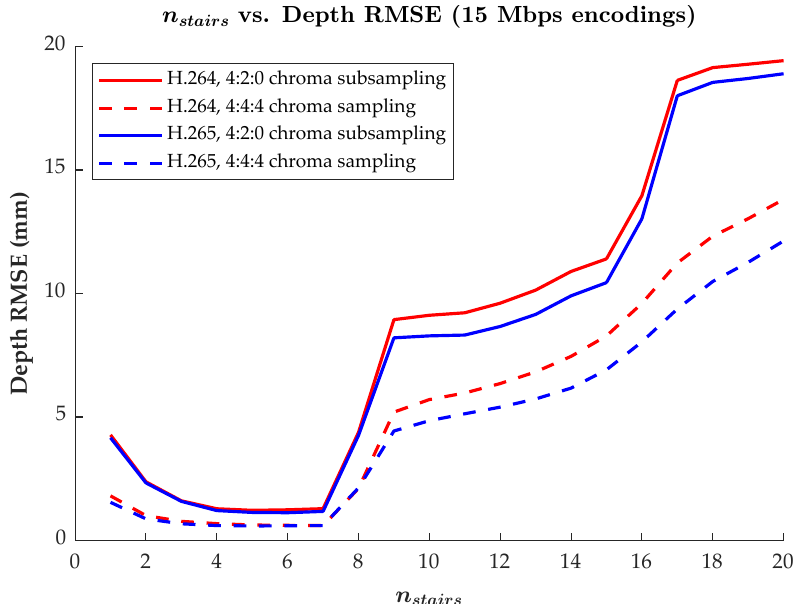
Figure 8. Plot of the MWD encoding parameter n stairs versus the RMSE in the recovered depth values. Results for the H.264 and H.265 codecs with both 4:2:0 chroma subsampling and 4:4:4 chroma sampling are included for comparison, with target average bitrates of 15 Mbps. Each RMSE is measured as an aggregate over an entire 582-frame reference video encoding. Other settings were as described in the first paragraph of Section